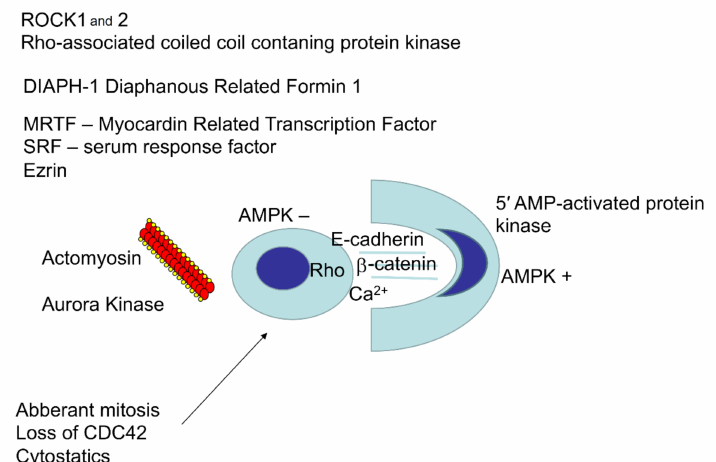
Figure 2. The main known molecules regulating entosis. The central part represents a schematic view of the cell–cell interaction during entosis. On the left, the interior cell is rounded after losing its contact with the substrate. On the right, the outer cell wraps around the inner cell and has a crescent-shaped nucleus. Both cells interact through formation of adhesion junctions mediated by E-cadherin, β -catenin, and calcium ions. The protein kinase AMPK is active in the outer cell and inactive in the inner one. On the left, there is a list of molecules that are active in the inner cell. The arrow indicates factors inducing entosis in cancer